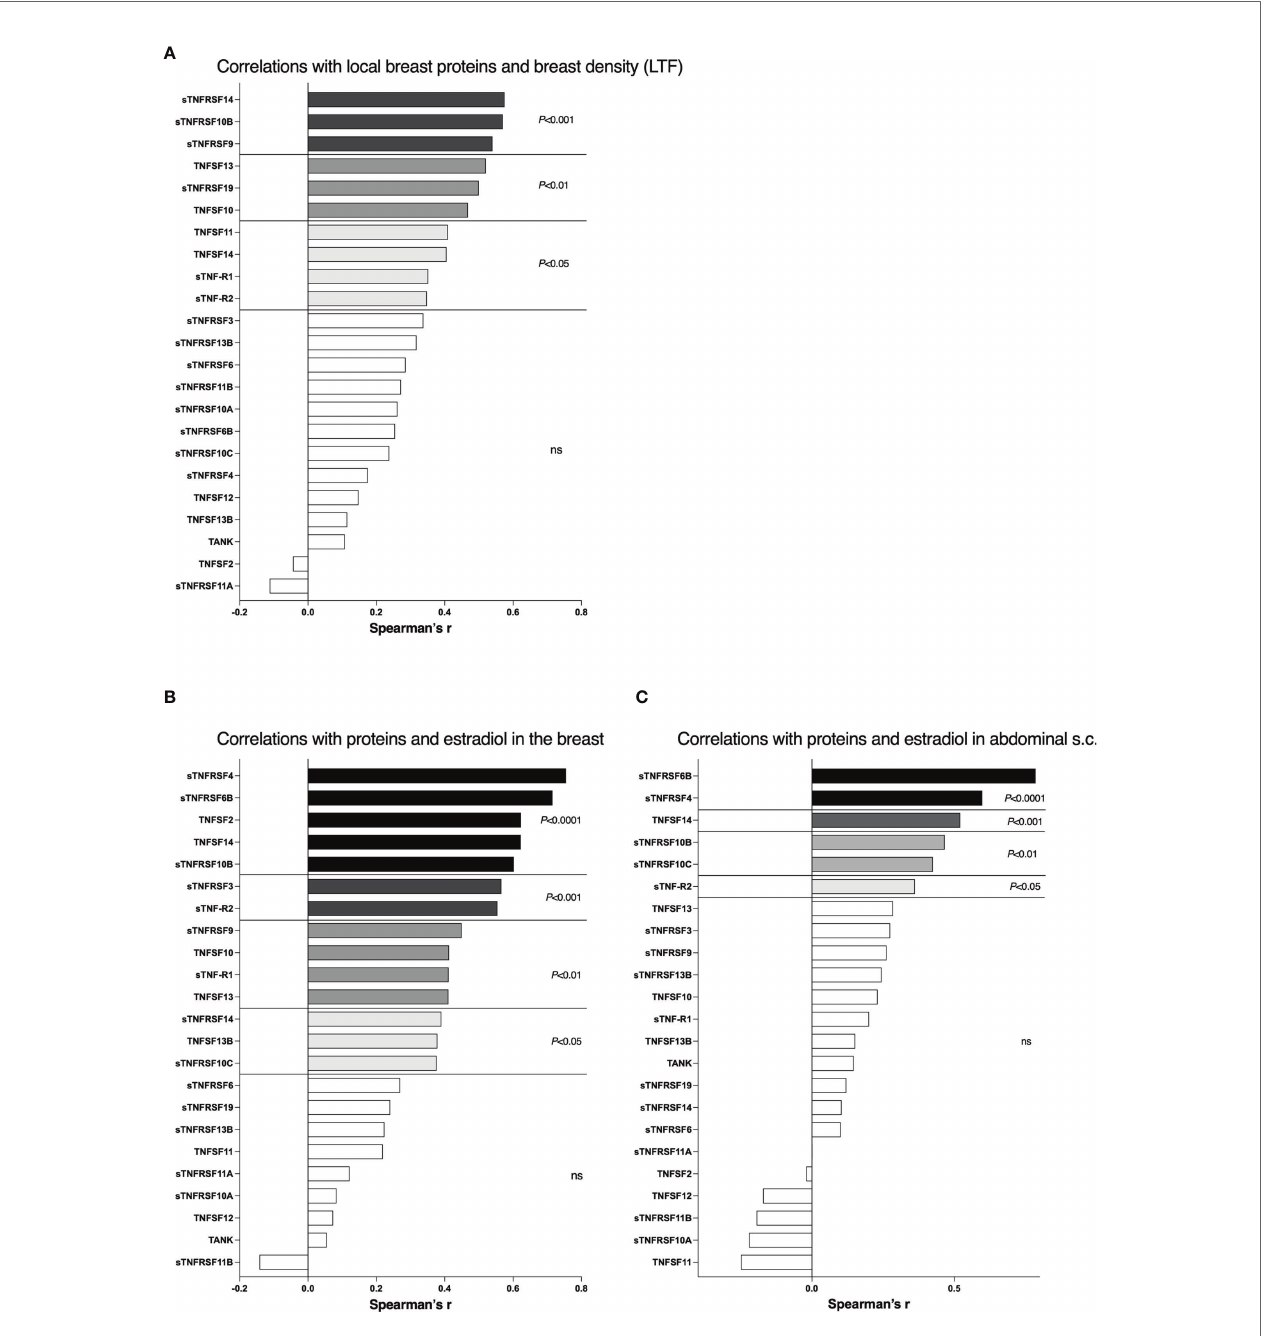
FIGURE 5 | Correlations between local breast levels of soluble TNFRSF and TNFSF with breast density and local breast estradiol levels. A total 40 postmenopausal healthy volunteer women, attending the regular mammography-screening program and 19 healthy premenopausal women underwent microdialysis of their left breast for sampling of extracellular proteins in vivo . Proteins and estradiol (E2) were quanti fi ed in the microdialysate as described in the materials and methods section. Breast density was quanti fi ed as lean tissue fraction (LTF) determined in the MRIs. (A) Correlations of local breast levels of TNFSFs/sTNFRSFs and LTF in postmenopausal women. (B) Correlations of local breast levels of TNFSFs/sTNFRSFs and local breast estradiol levels. Premenopausal women and postmenopausal women with dense breasts were included. (C) Correlations of local levels of TNFSFs/sTNFRSFs and local estradiol levels in abdominal s.c. fat. Bars represent Spearman ’ s Rank correlation coef fi cient. White bars, not signi fi